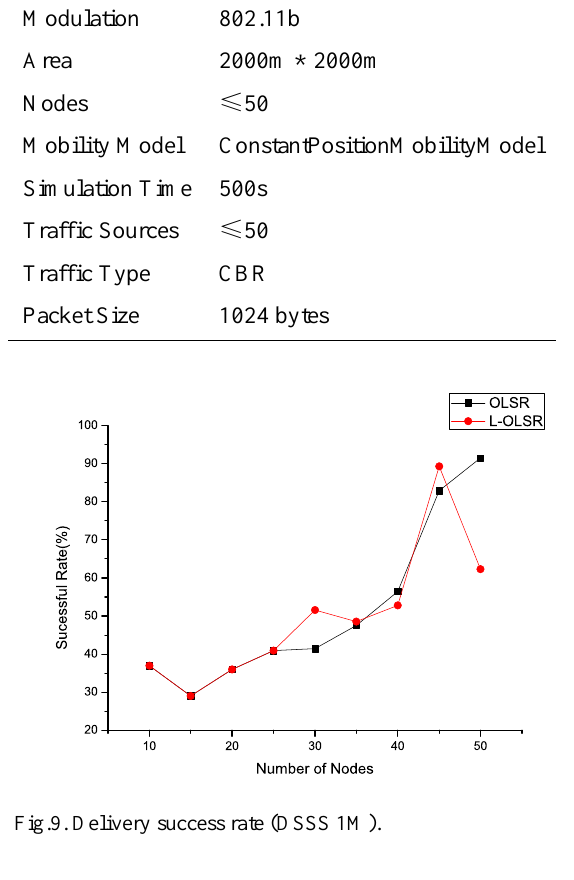
Table 6 Simulation parameters.